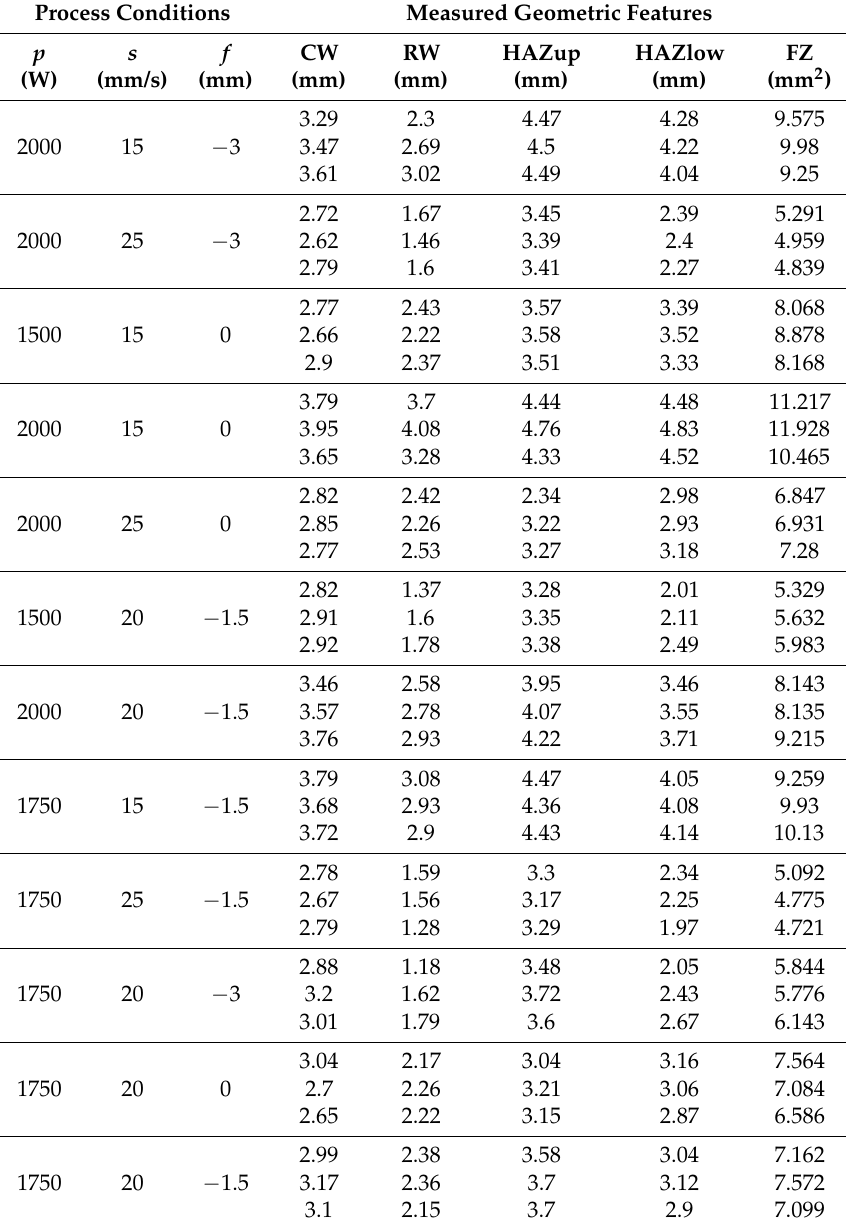
Table 4. Measured values of the weld bead geometric features under the different experimental process conditions (each process condition was tested three